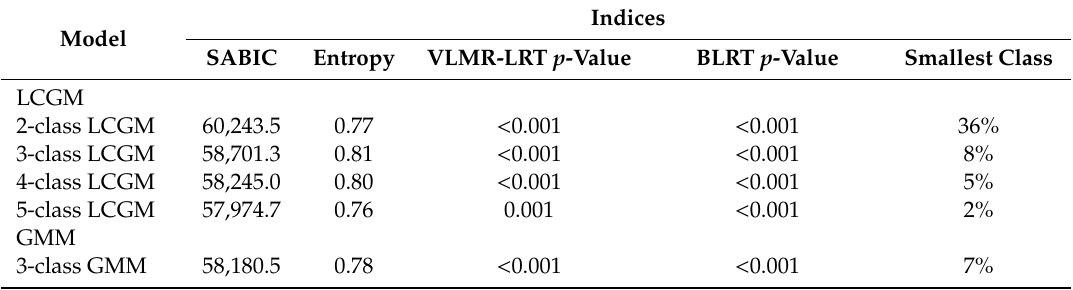
Table 2. Performance of latent class growth models and growth mixture models.